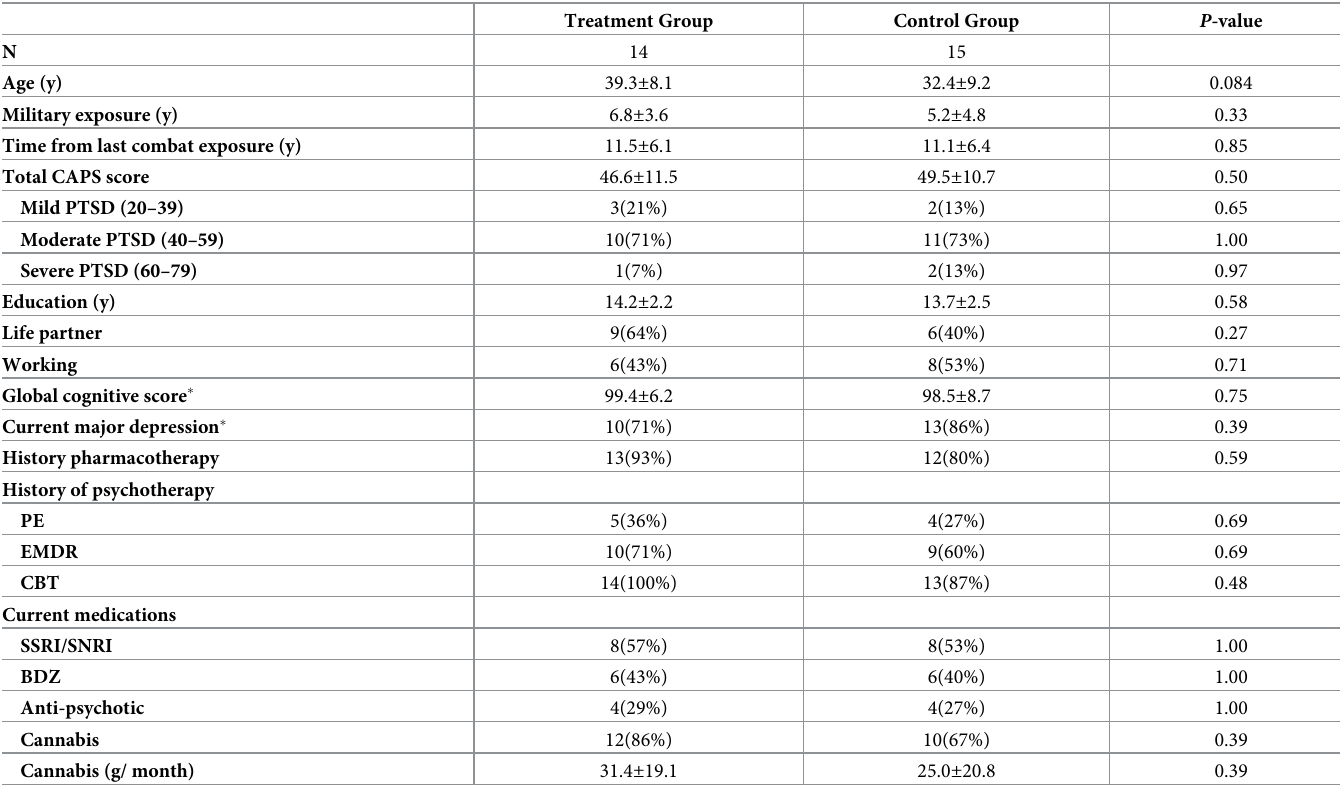
Table 1. Patient characteristics.